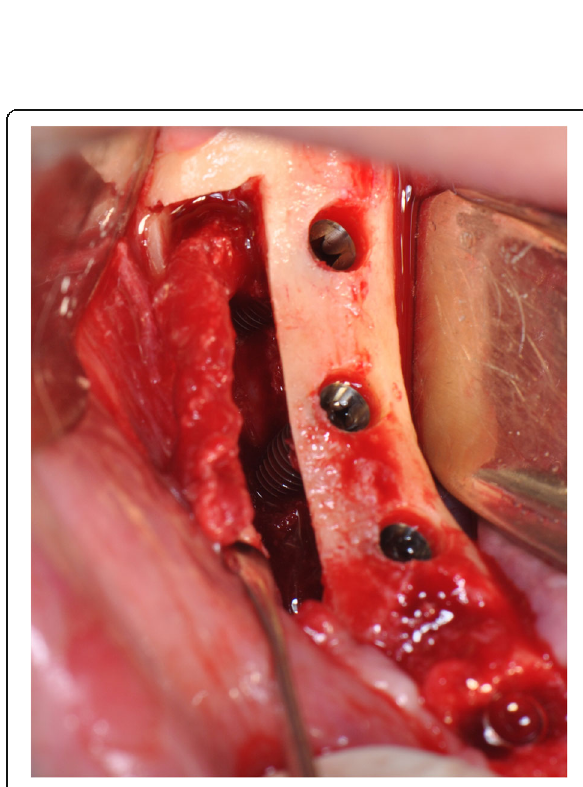
Fig. 4 The neurovascular bundle is mobilised and retracted laterally while the implants are